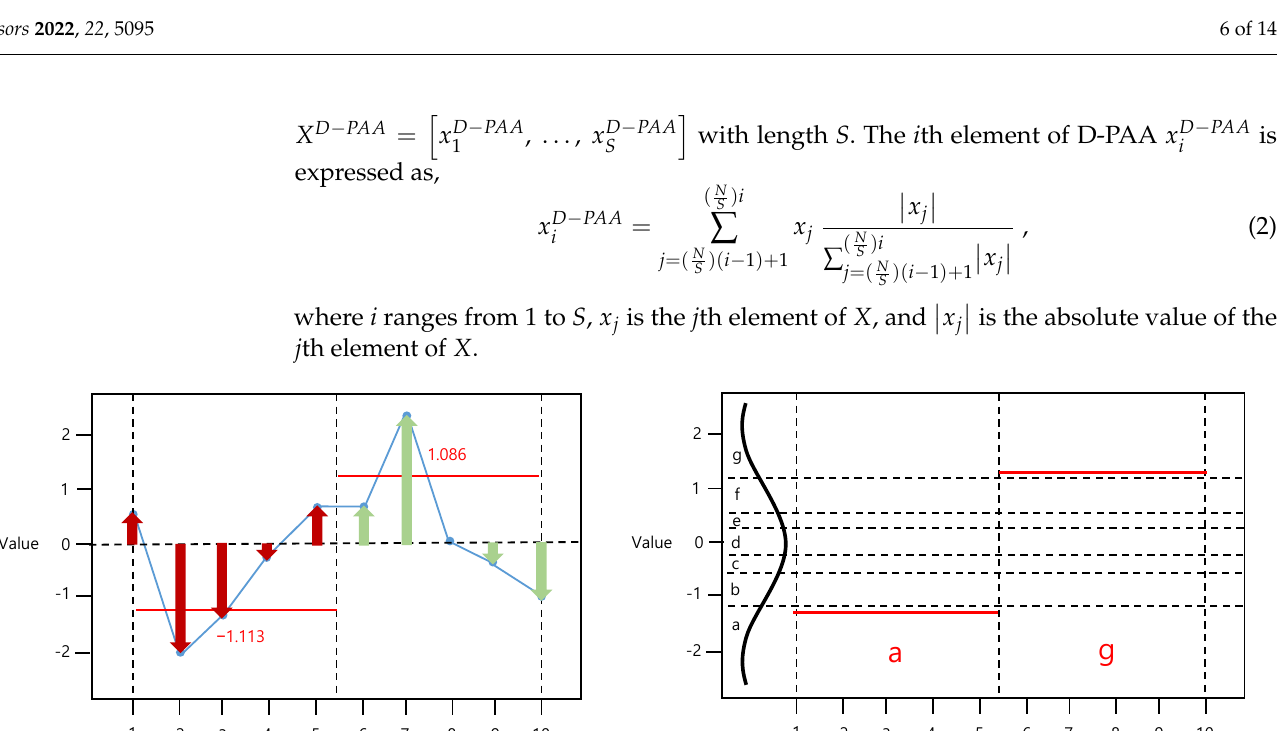
Figure 2. Procedure of ( a ) D-PAA ( t_size = 5) and ( b ) D-SAX ( n_bins = 7). Afterward, a previously generated D-PAA vector X D − PAA = is converted into a symbol vector X D − SAX = same discretization and symbolization are processed similar to that of the SAX. In this study, we refer to this method as distance-based SAX (D-SAX). The process of D-SAX is shown in Figure 2.